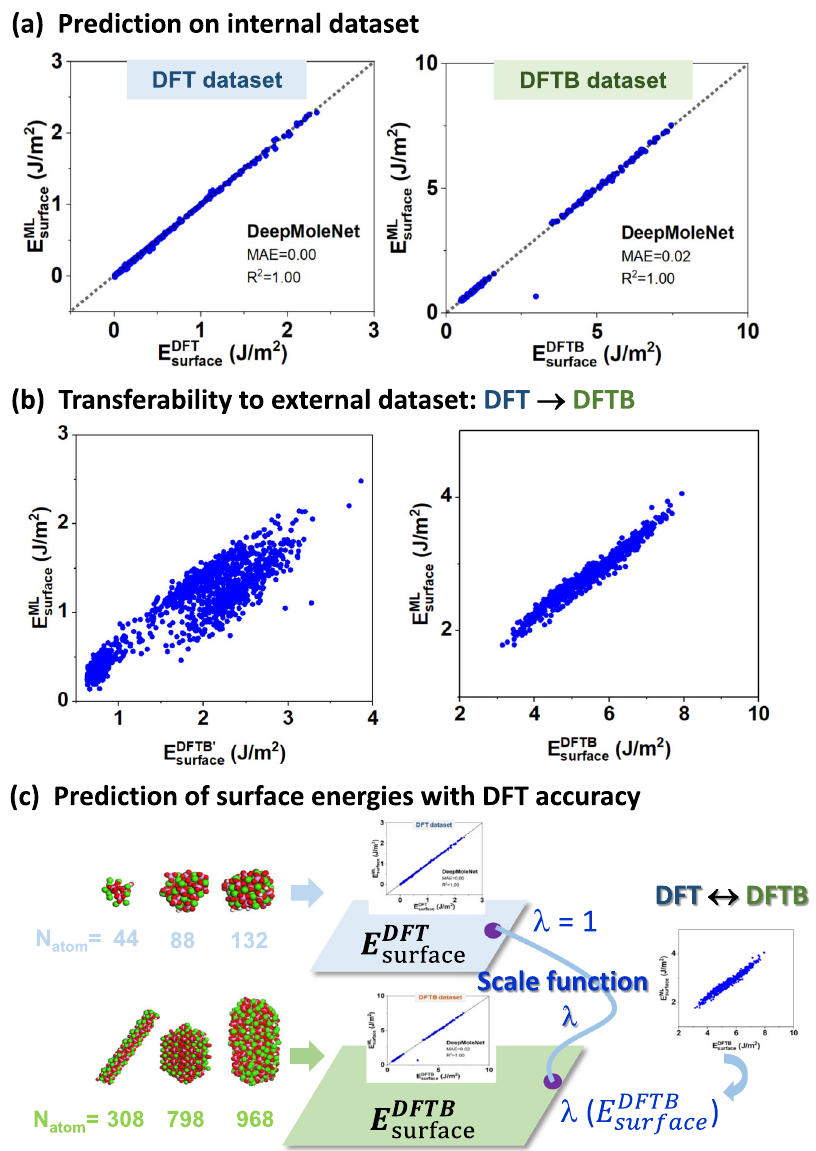
Fig. 6 Deep learning on internal and external datasets and the scale function bridging different scales. a Learning on internal dataset: training and testing on the same DFT or DFTB dataset, respectively. b Learning on external dataset: training on DFT dataset and then making predictions on DFTB dataset in different energy regions. c Prediction of DFT accuracy surface energies for the medium-sized nanoparticles with the number of atoms, N atom , up to 1000 using the scale function learned from the energy relation between two different